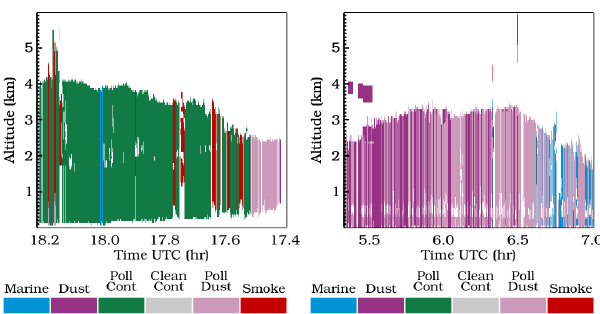
Fig. 8. Aerosol classification mask for data obtained by the airborne HSRL-1, but processed using the CALIOP retrieval software. Left panel shows the aerosol classification for 4 August 2007 near Wash- ington DC (as in Fig. 6) and the right panel is 24 August 2010 in the Caribbean Sea (as in Fig.